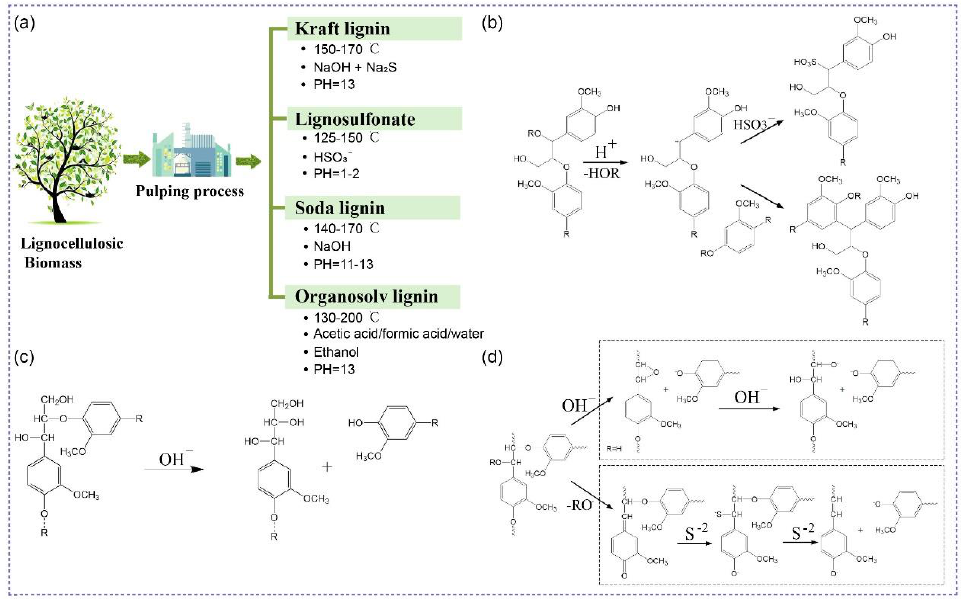
Figure 2. ( a ) Preparation of industrial lignin by various pulping methods. ( b ) Schematic isolation reaction in sulfite process. ( c ) Hydrolysis of α -ether bonds in soda process. ( d ) Kraft reactions of β -aryl bonds in phenolic and nonphenolic phenylpropane units (From Refs. [6,15,25,34]).